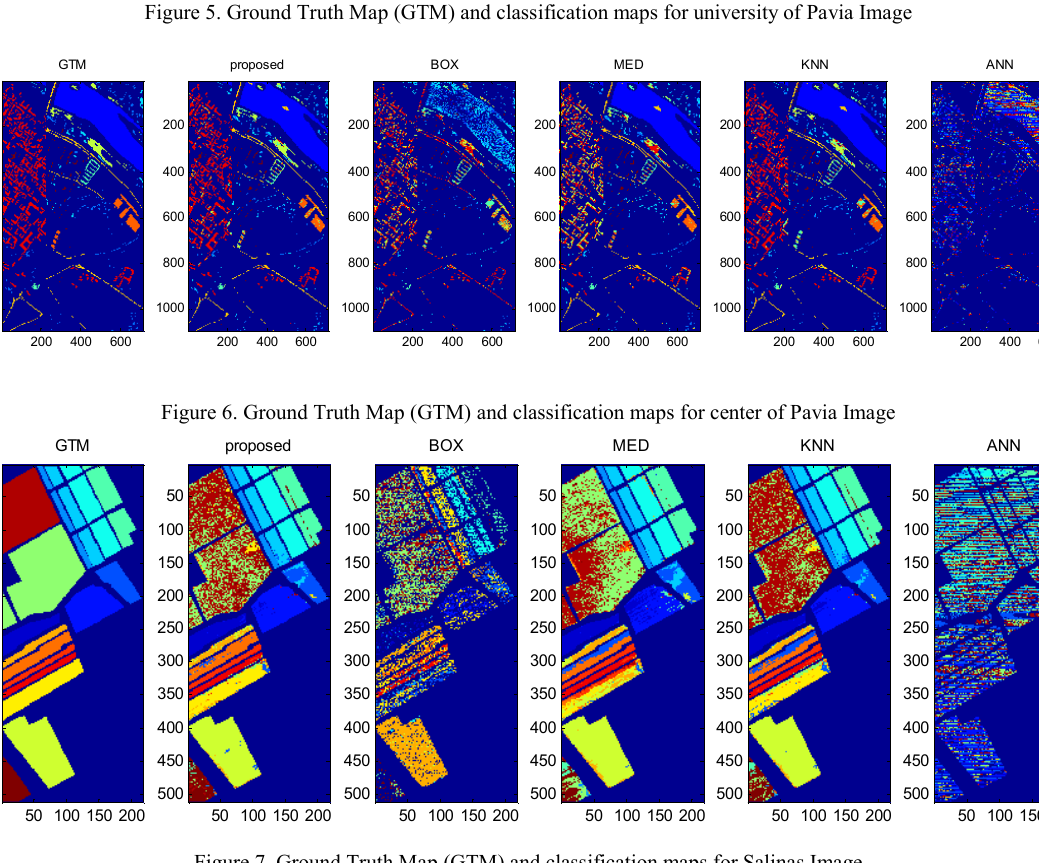
Figure 7. Ground Truth Map (GTM) and classification maps for Salinas Image